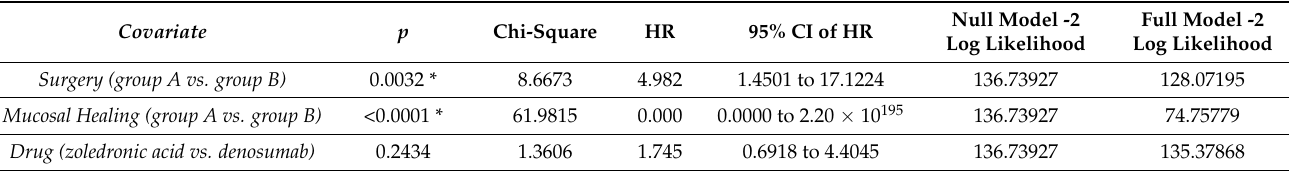
Table 2. Univariate Cox regression: surgical treatment (resection vs. debridement) and mucosal healing are statistically correlated to recurrence.